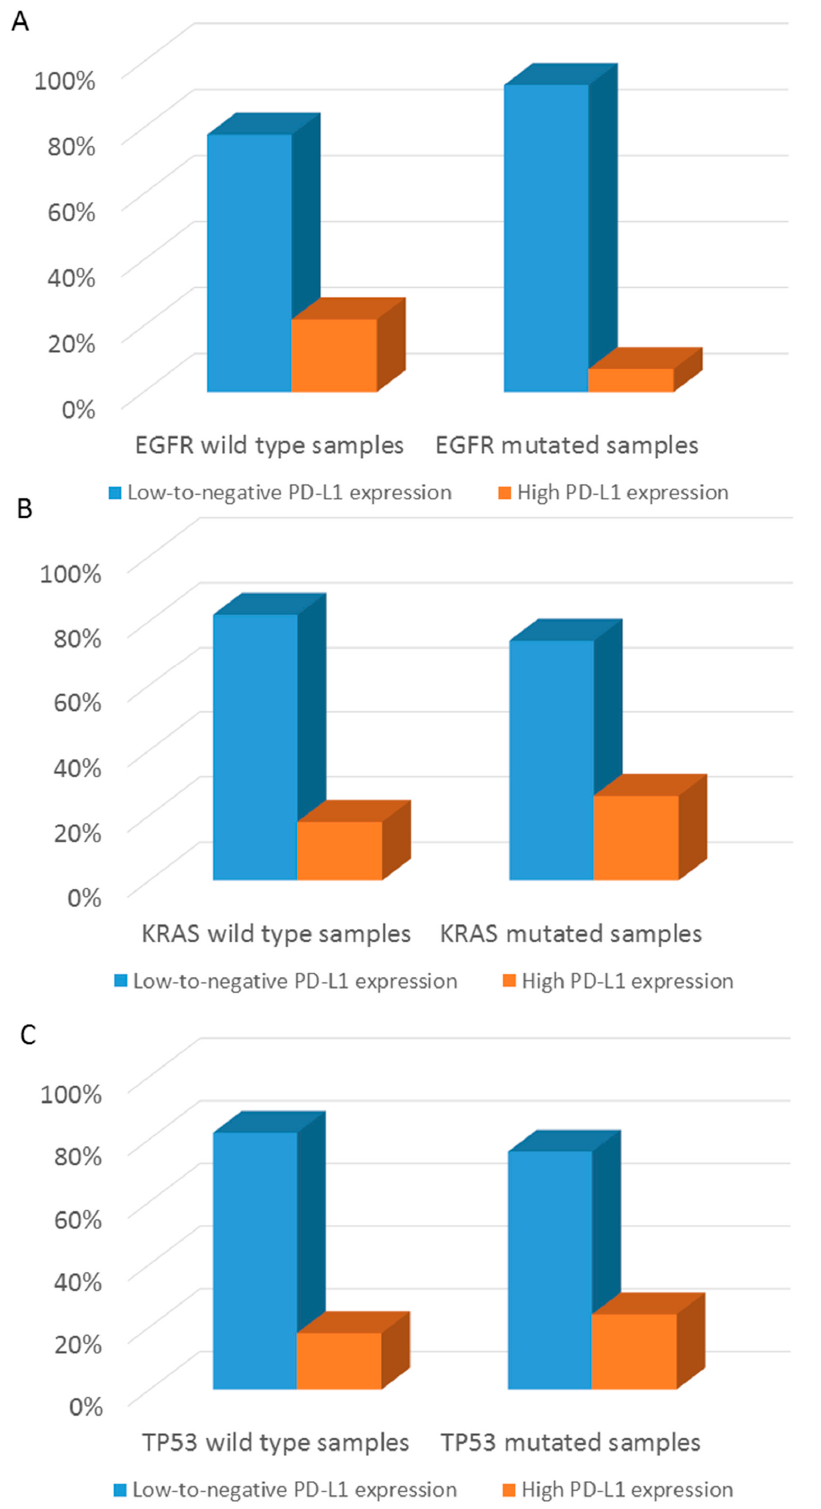
Figure 1. Associations between PD-L1 expression and genomic alterations in the entire cohort. ( A ) Bar graphs show the percentage of EGFR -mutated samples with either low-to-negative PD-L1 expression or high PD-L1 expression. ( B ) Bar graphs show the percentage of KRAS -mutated samples with either low-to-negative PD-L1 expression or high PD-L1 expression. ( C ) Bar graphs show the percentage of TP53 -mutated samples with either low-to-negative PD-L1 expression or high PD-L1 expression.